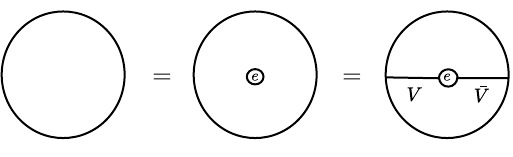
Figure 2 . In this figure we have flattened out the cigar geometry into a disk. On the right figure, we can view the lower half of the annulus as a path integral preparation of a factorized state with a shrinkable boundary condition at the entangling surface. Quantizing Z ( β ) with respect to the time variable around the origin shows that it can be viewed as the trace of a reduced density matrix on V